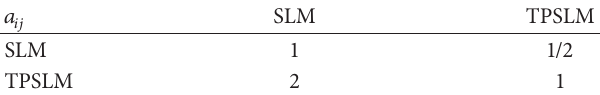
Table 8: Judgment matrix of reactive power fitting degree.